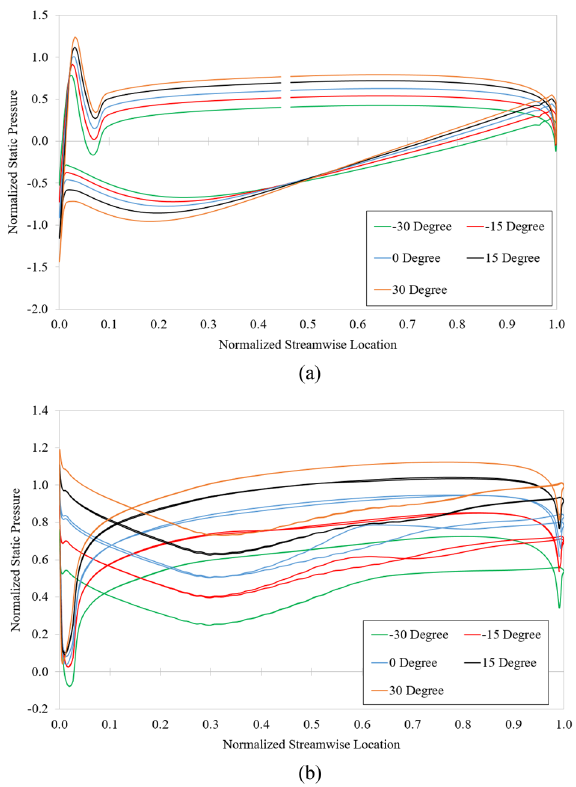
Figure 22. Blade loading at 50% span for various setting angles of IGV. ( a ) Impeller and ( b )